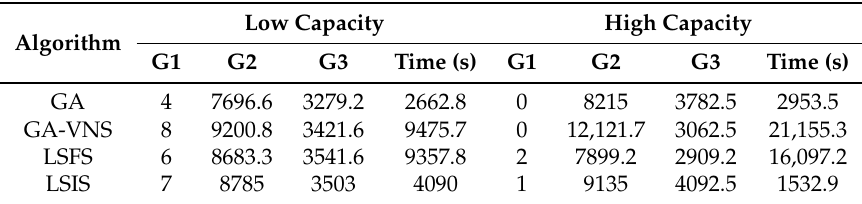
Table 5. Result of Case 5 (low capacity: 2000; high capacity: